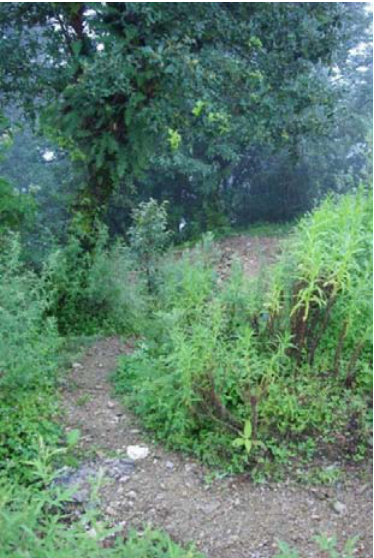
Figure 5. Cut-off trail near Dochu